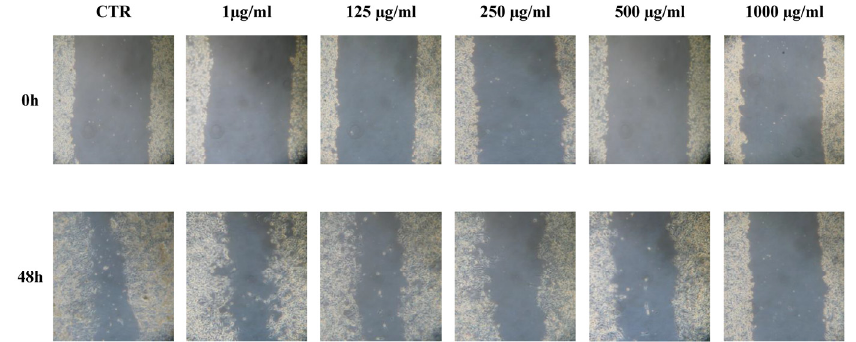
Figure 1. Wound ‐ healing assay. B16F10 and MDA ‐ MB231 cells were plated on a six ‐ well plate. The cell layer was scratched and incubated with Ganoderma lucidum at different concentrations (1 μ g/mL; 125 μ g/mL; 250 μ g/mL; 500 μ g/mL; 1000 μ g/mL) for 48 h. The images were captured by a Leica microsystem microscope with phase contrast. The experiment was repeated at least three times. CTR = control.